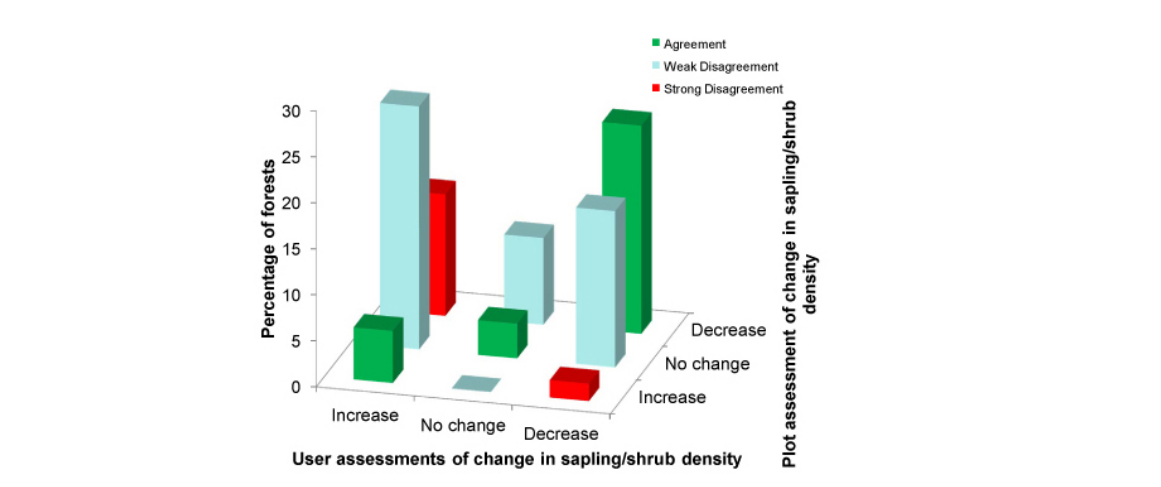
Fig. 4. Plot assessment of change in sapling/shrub density vs. user assessment of change in sapling/shrub